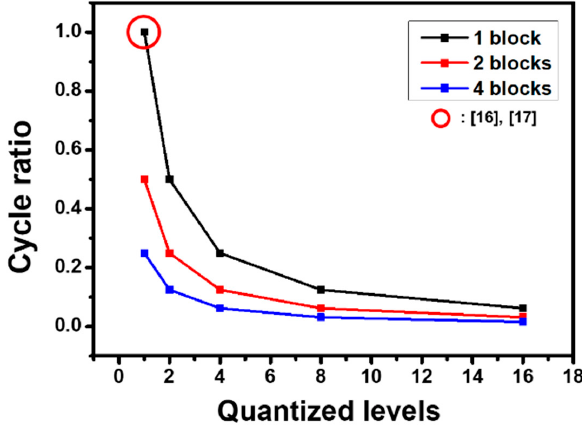
Figure 8. Cycle ratios for increasing quantized levels.